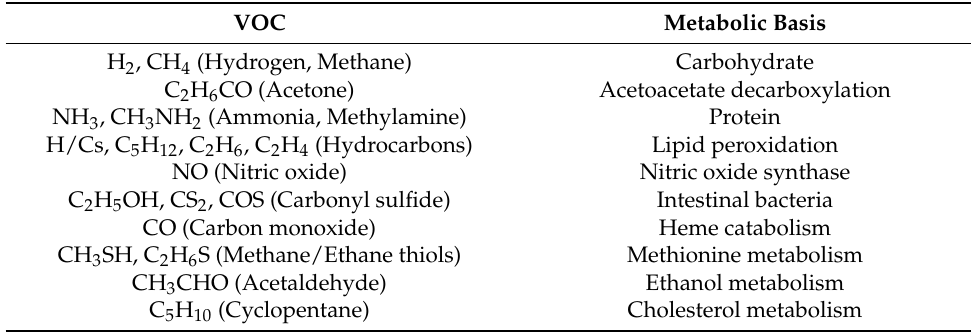
Table 2. Biochemistry of certain